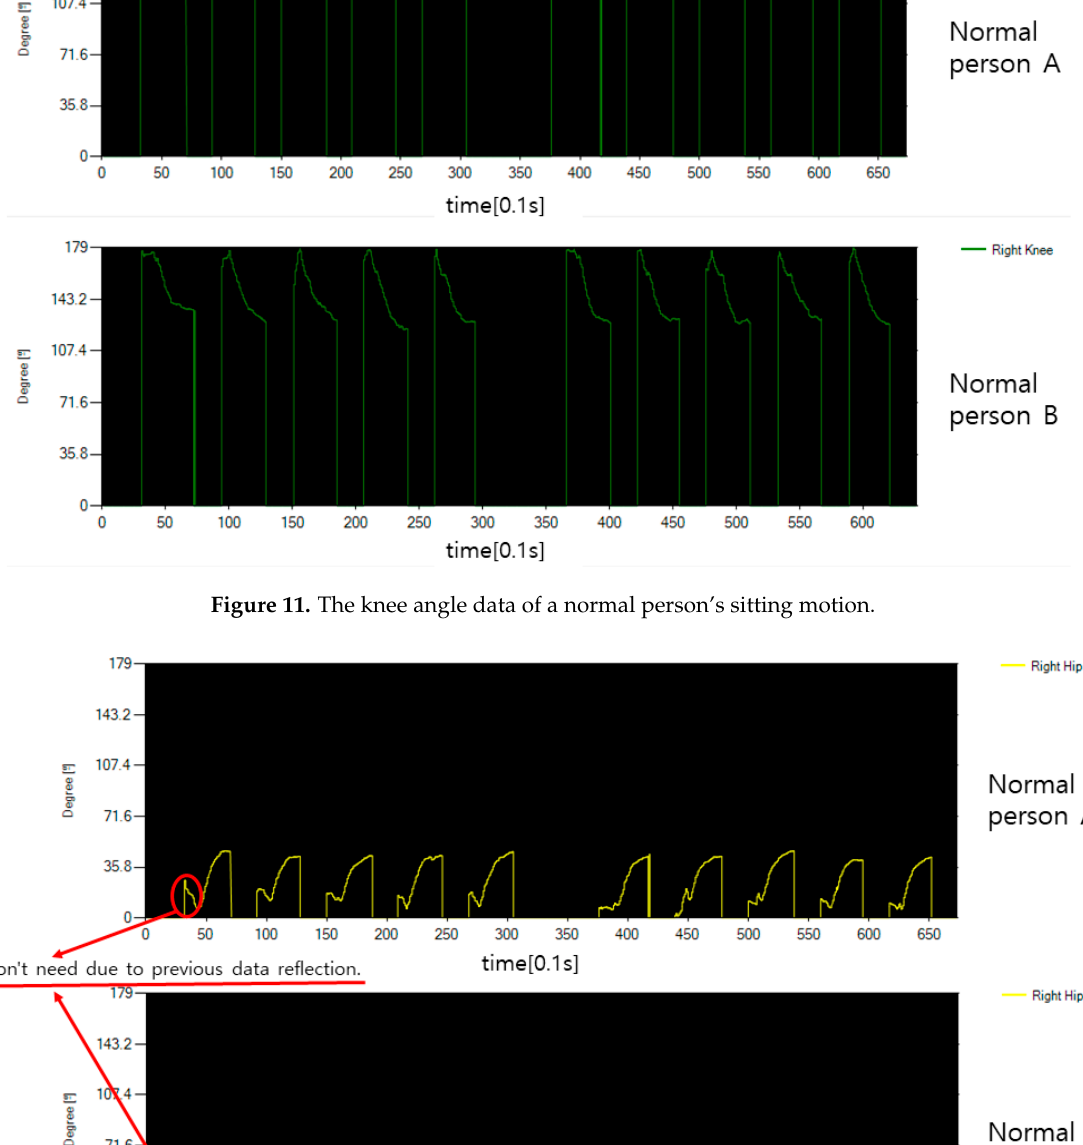
Figure 11. The knee angle data of a normal person’s sitting motion.